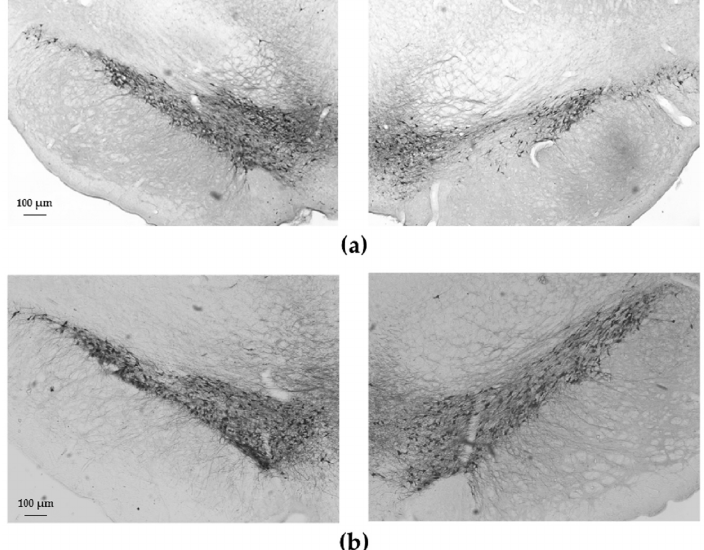
Figure 6. Tyrosine-hydroxylase (TH)-immunoreactivity in a representative 6-OHDA-treated control ( a ); and enriched animal ( b ). Sections were photographed from the substantia nigra ( a , b ) from both the lesioned ( right panels ) and the contralateral sides ( left panels ).